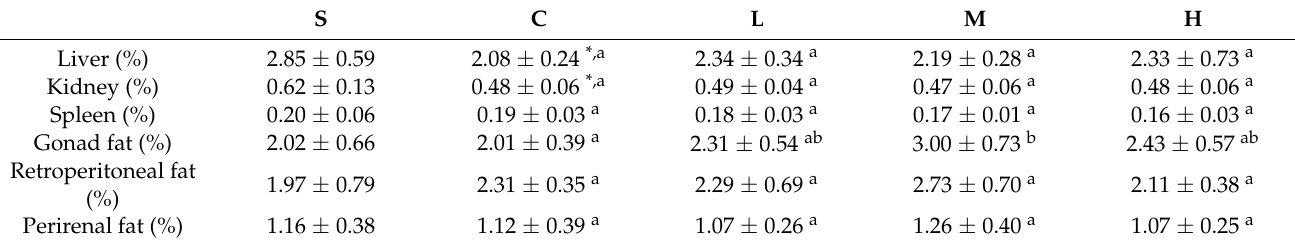
Table 6. The relative organ weights after an ovariectomy and 8 weeks of a dietary intervention.